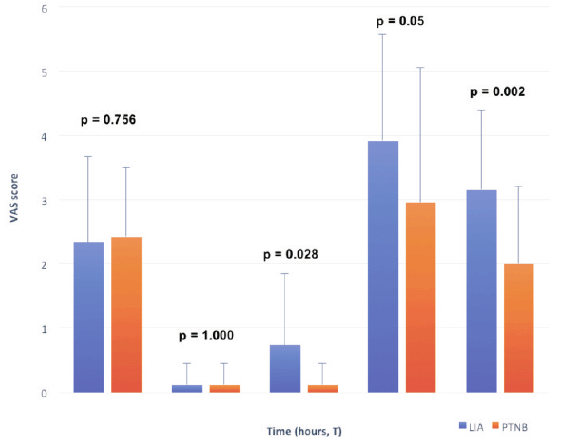
Variation of pain in the first day after surgery. At T0 and Fig. 3: T1 no significant differences could be detected in the VAS score but from T2 until discharge from the hospital the study group presented a significant reduction of VAS. T0: before the surgery; T1 3 hours after surgery; T2 6 hours after 318 surgery; T3 12 hours after surgery; T4 24 hours after surgery. (PTN: posterior tibialis nerve; PTA: posterior tibialis artery).